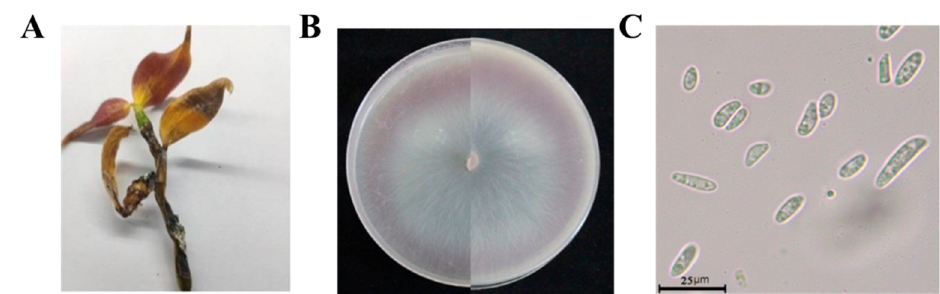
Figure 3. Isolation of pathogenic fungi from soft rot in Dendrobium officinale . ( A ) = The soft rot on Dendrobium officinale plant in the field; ( B ) = the morphology of strain XY1E208 after growing on PDA medium for 7 days; ( C ) = conidia morphology of strain XI1E208.